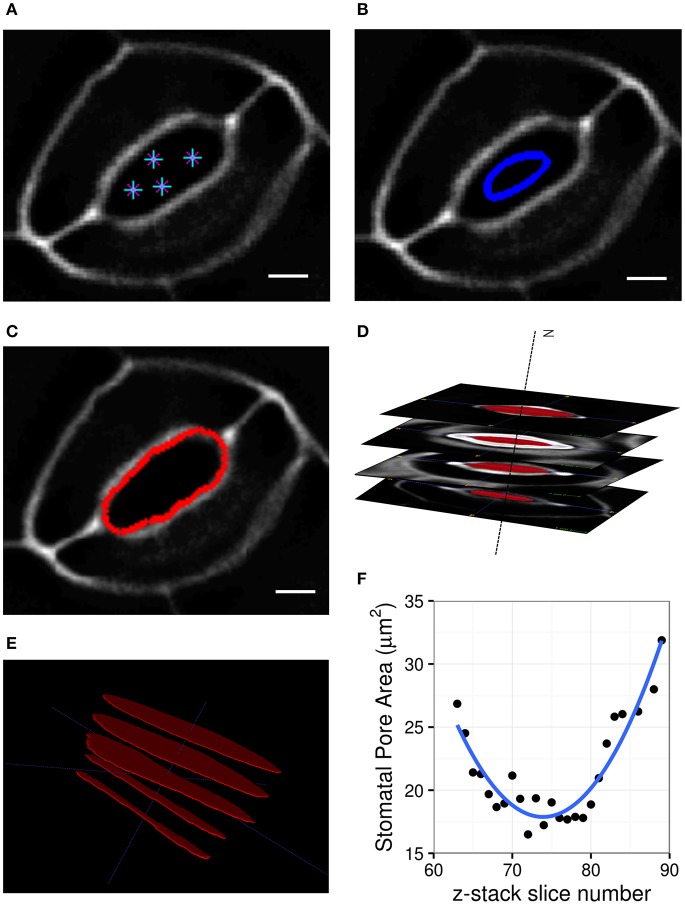
Procedure of stomatal pore area measurement. (A) A few points are input by the user on a single slice of the z-stack. (B) A curve is initialized from these points. (C) The curve expands and evolves according to edges in the image and fits the pore opening. (D) Cross-sectional view of detected pore areas after segmentation through a z-stack. (E) Pixel counts within the extracted pore areas are calculated, and the smallest one is converted to pore area in μm2. (F) Stomatal pore areas of z-stack slices are fitted to a robust quadratic equation to find the respective minimum value representing the pore area of a given stomatal complex. Scale bars represent 5 μm.